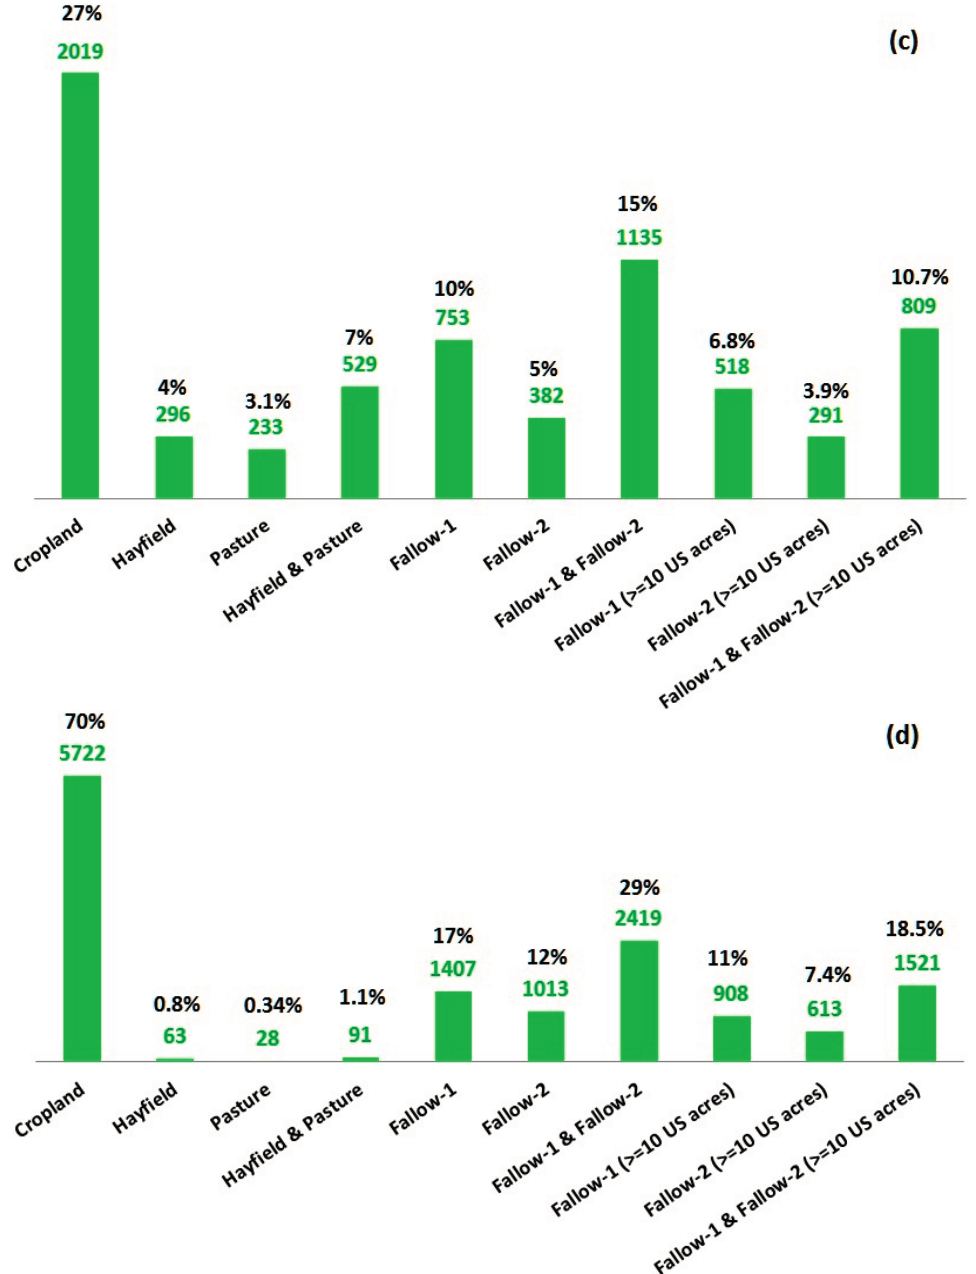
Figure 6. Land area (hectares) and percent coverage of current land uses within the four townships of Fort Fairfield ( a ), Presque Isle ( b ), Easton ( c ), and Caribou ( d ). Percentages are based on total open land (“open land” refers to all land uses except for forests, water bodies, wetlands, wastelands, and developed lands). The last three categories are for plots that are equal to or greater than 10 U.S. acres (or 4.05